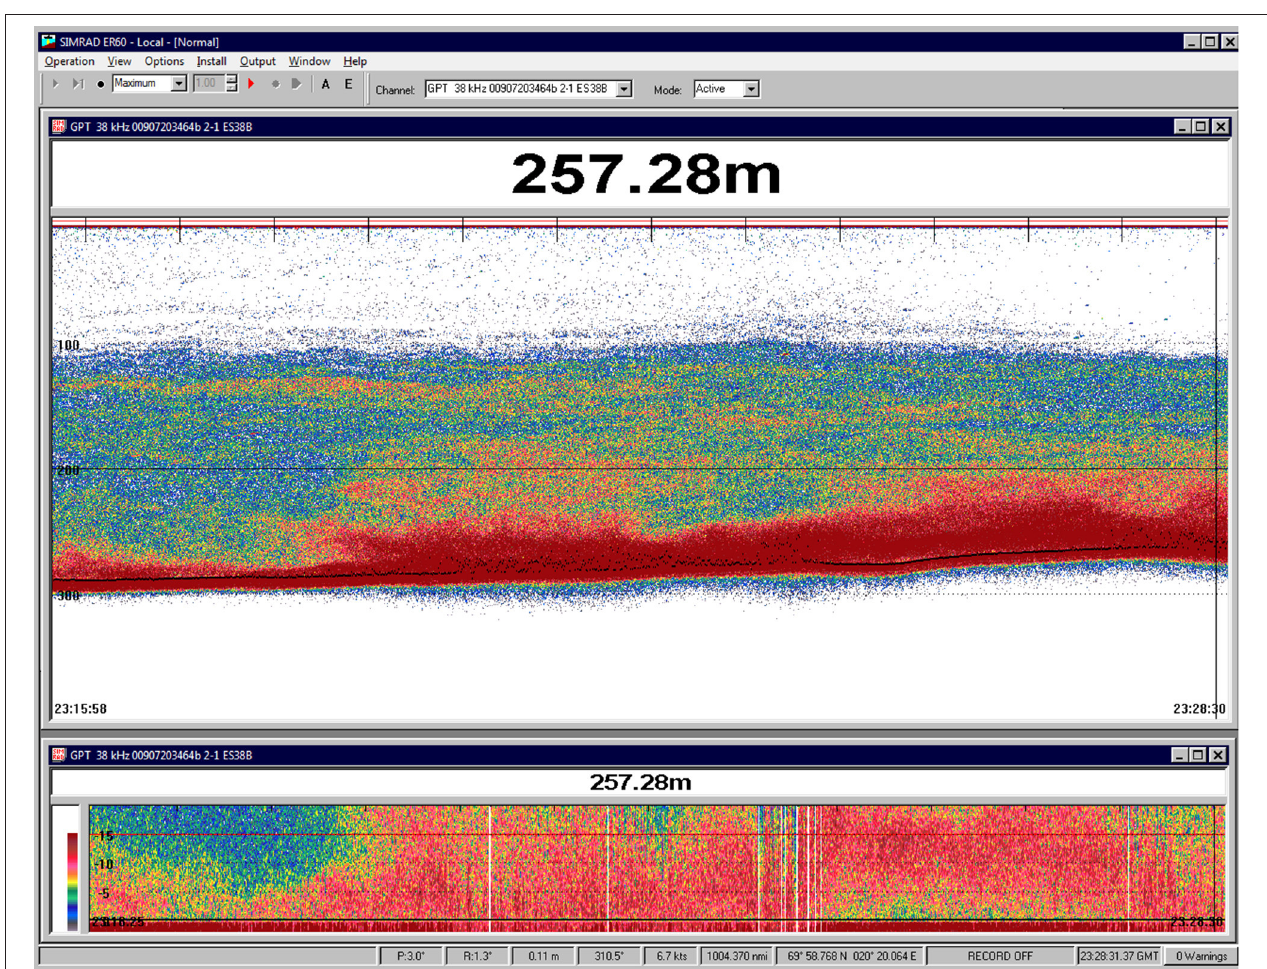
FIGURE 15 | Upper part: Pelagic 38kHz screendump echogram (Simrad EK60/ER60 system, www.simrad.com/ek60) from the outer part of Lyngen during midnight 26/27 November 2015 (23:15:58-23:28:30 UTC). Lower part: Bottom channel 38kHz echogram, 0–20m above the